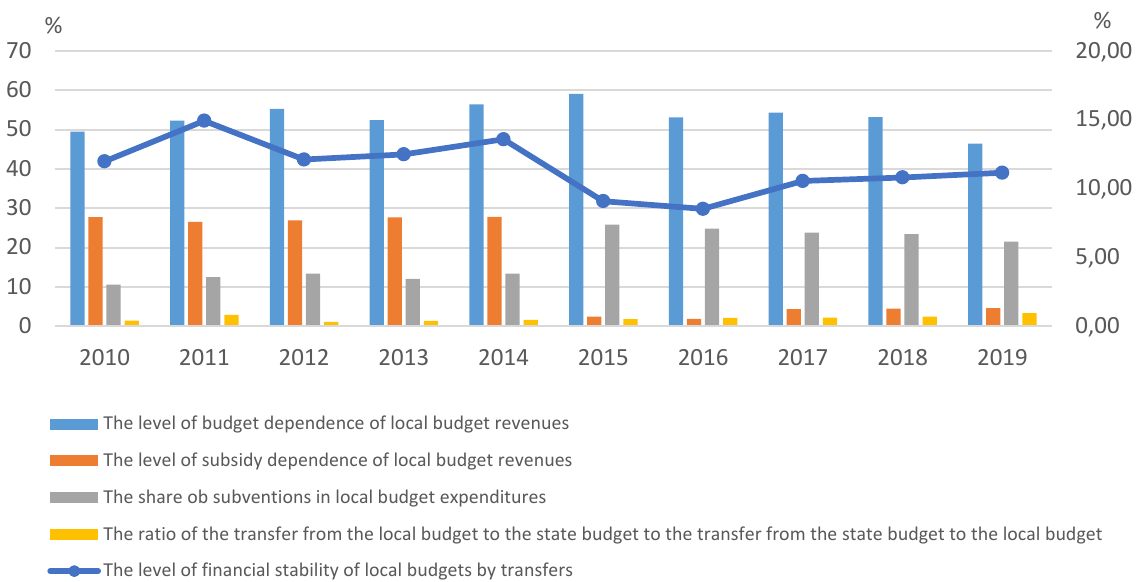
Figure 7. Dynamics of the level of local budgets’ financial sustainability in Ukraine by transfers for